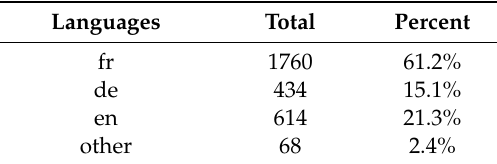
Table A35. Primary languages (lu).